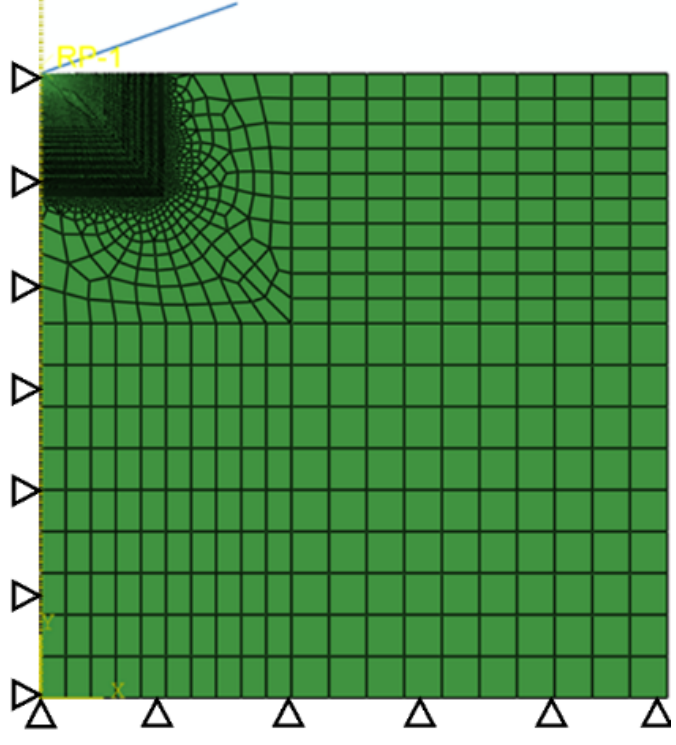
Figure 3. The boundary conditions and meshing of the finite element